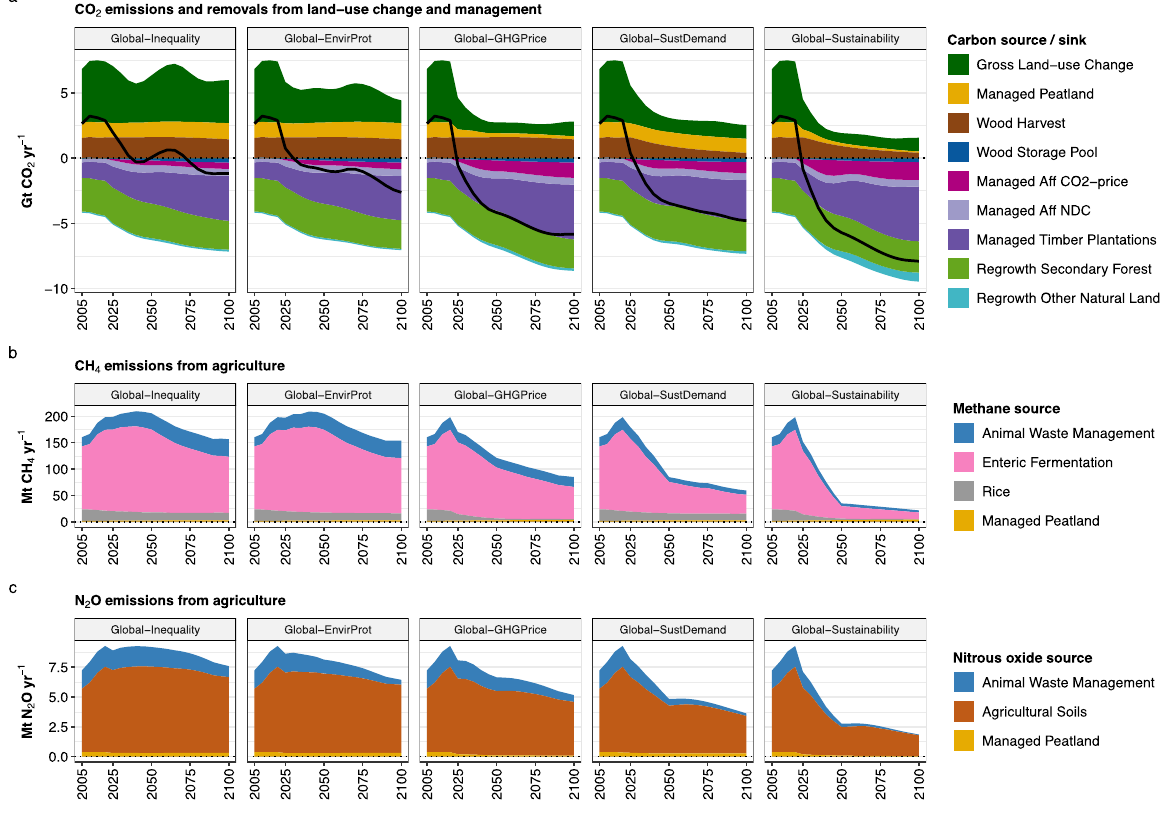
Fig.7|AFOLUGHGemissionbreakdownbysource. Dataareshownatgloballevel for fi ve scenarios. a shows CO 2 emissions and removals from land-use change and management.Carbonlossesconsistofemissionsfromdeforestation,conversionof non-forestecosystems,drained peatlands,and woodharvest.Carbongainsconsist of carbon storage in wood products, re/afforestation (Aff CO2-price and Aff NDC),